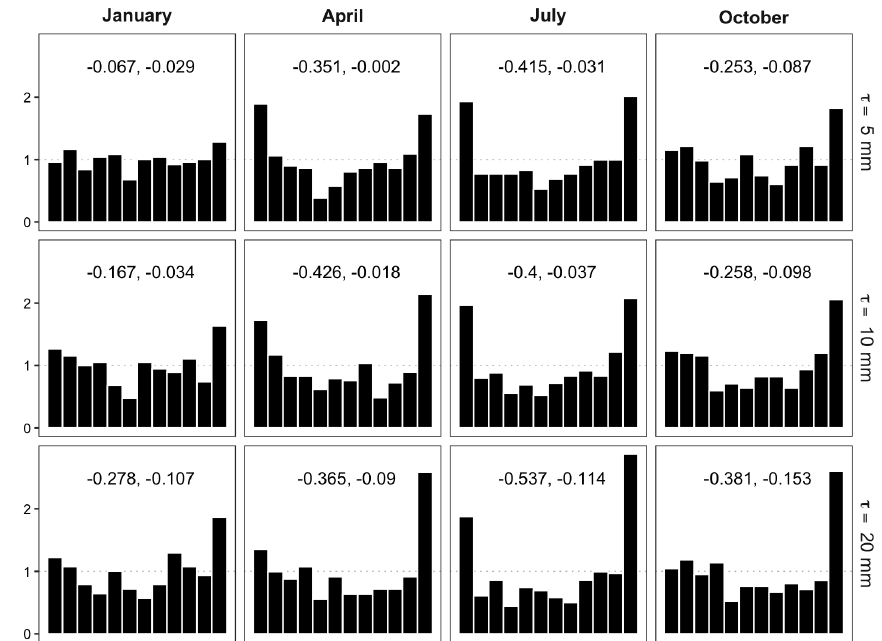
Figure 9. FTE histograms for downscaled fields at different thresholds in representative months. Estimated β -score (left) and β -bias (right)